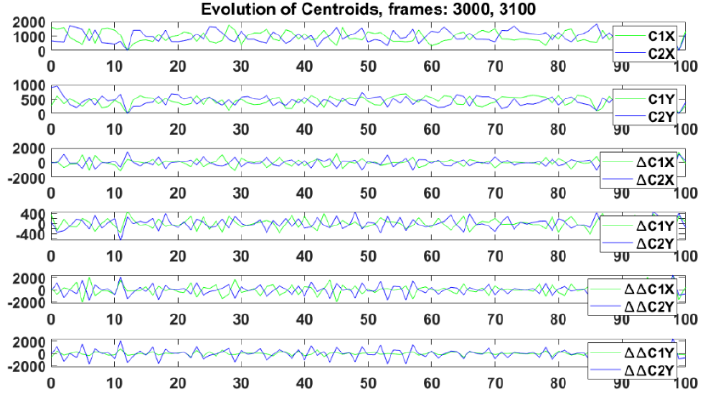
Figure 8. Generation of activity centroids by k-means, N = 2, Cluster 1 (C1) and Cluster 2 (C2) in a frame (frame size x in pixels, frame size y in pixels).